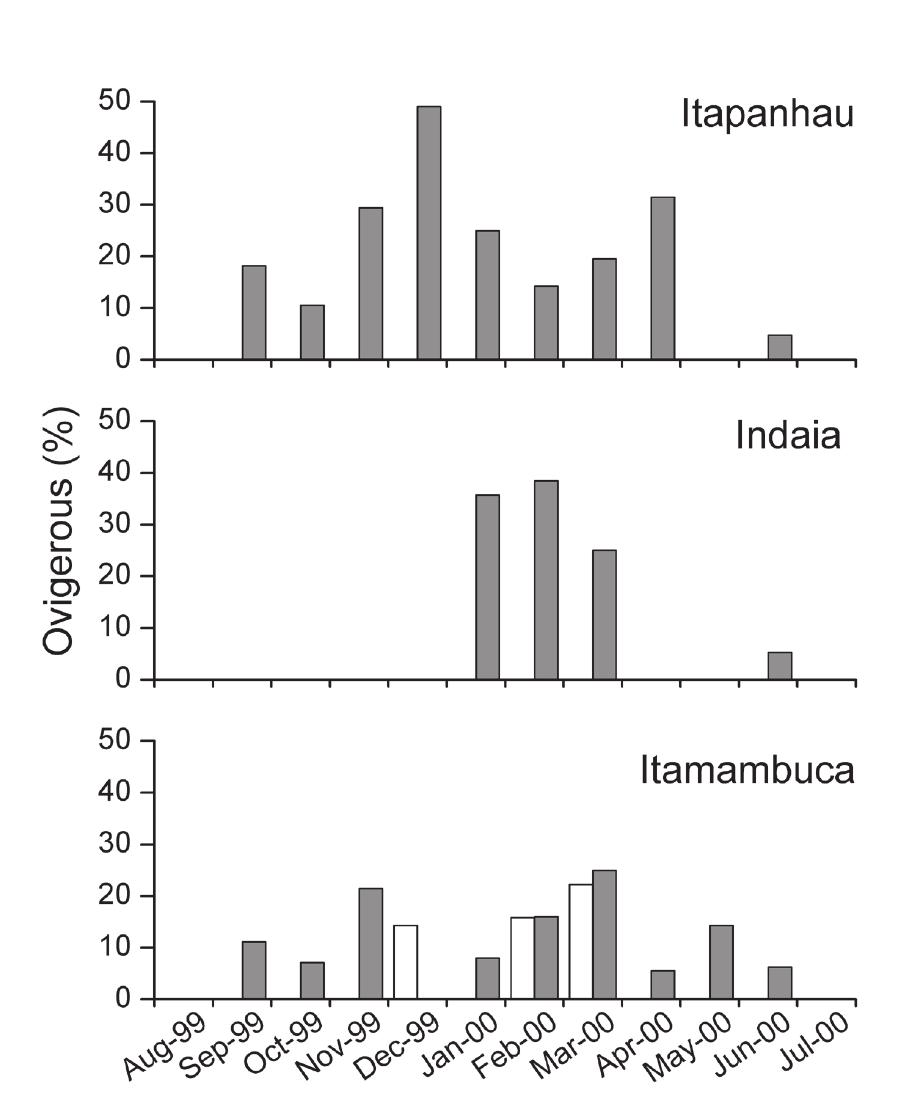
Figure 5. Minuca vocator (Herbst, 1804). Proportion of ovigerous females sampled by CPUE (catch-per-unit-effort – gray columns) and QT (quadrat technique – white columns) throughout the year, in the studied mangroves.